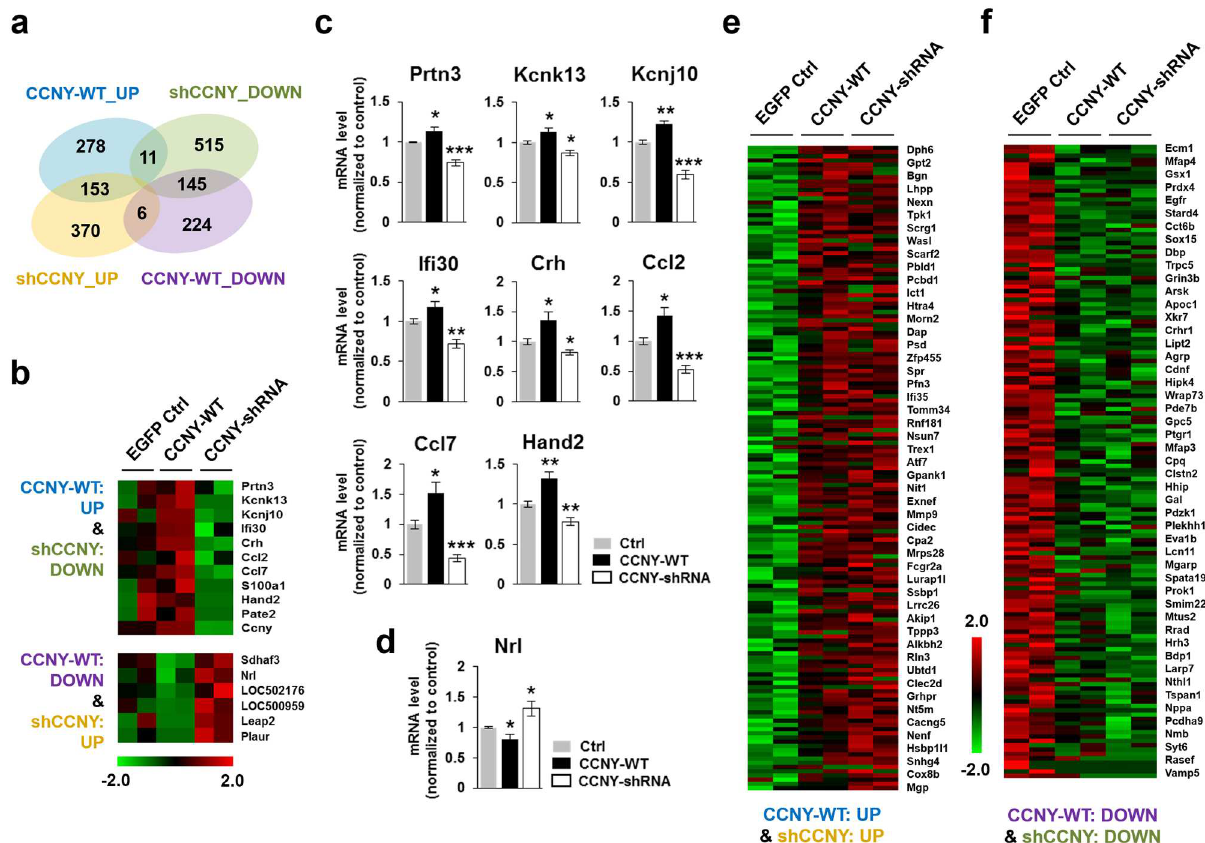
Fig 6. Analysis of overlapping DEGs controlled by CCNY overexpression and knockdown. ( a ) Venn diagram showingthe overlaps among the four categories. ( b-d ) Some genes are oppositely regulatedby CCNY overexpression and knockdown. ( b ) Heatmap for the genes overlapping up-regulated by CCNY overexpression and down-regulated by CCNY knockdown (upper). Heatmap for the genes overlappingdown-regulated by CCNY overexpression and up-regulated by CCNY knockdown (lower). ( c,d ) Several genesfrom ( b ) were validatedby qRT-PCR. n = 3–5 from 3 independentexperiments. * p < 0.05relative to control, ** p < 0.01 relative to control, *** p < 0.001 relative to control, ns, not significant,student’s t test. ( e , f )Heatmapsfor the genes overlapping up-regulated by CCNY overexpression and up-regulated by CCNY knockdown ( e ) and the genes overlappingdown-regulatedby CCNY overexpression and down-regulated by CCNY knockdown ( f